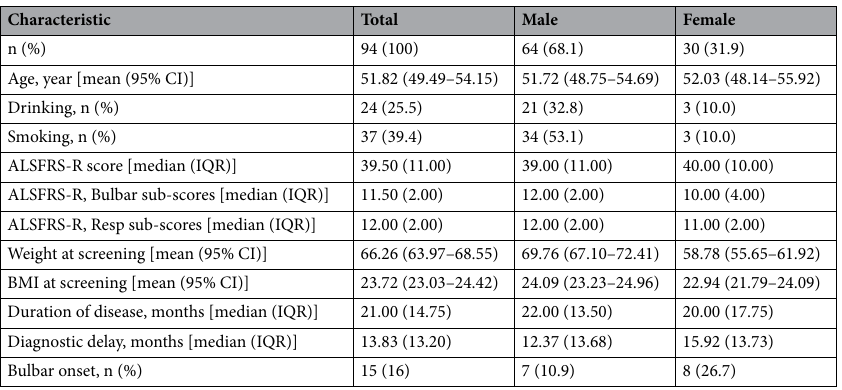
Table 1. Characteristics of ALS patients at the time of collection of baseline data. CI confidence interval, IQR interquartile range, BMI body mass index, ALS amyotrophic lateral sclerosis, ALSFRS-R ALS Functional Rating Scale-Revised.